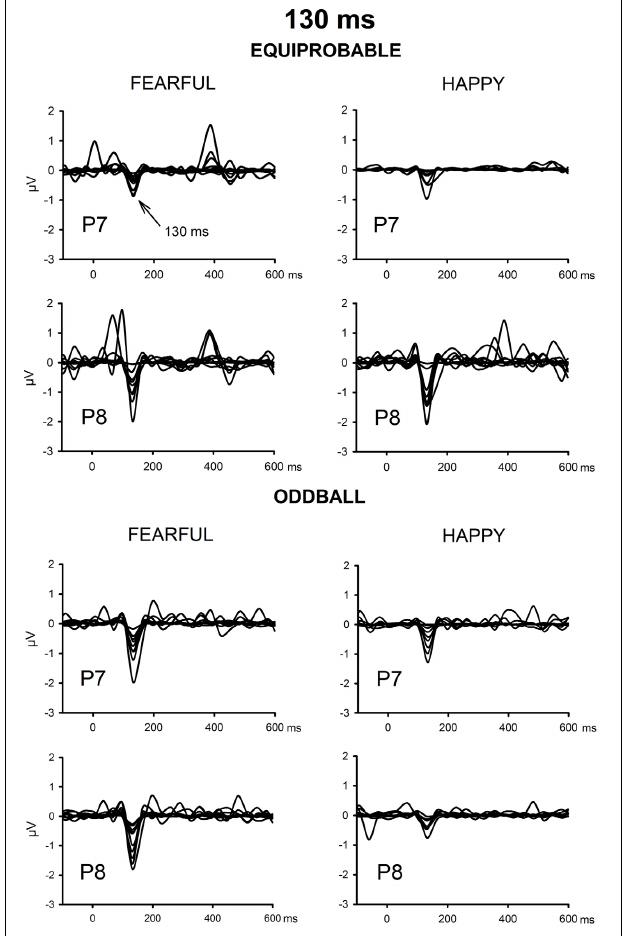
FIGURE 4 | Back-projected 130-ms components for each participant. Differential response waveforms (emotional minus neutral) at P7 and P8 electrodes are drawn separately for fearful and happy faces and for oddball condition and equiprobable condition groups.